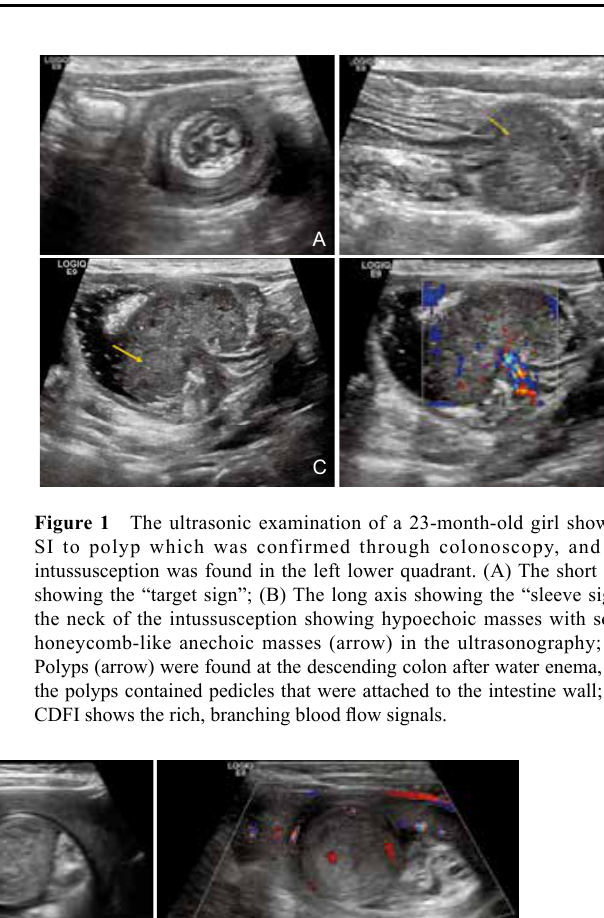
AB AB AB Figure 2 The ultrasonic examination of a boy (age: 7 years, 5 months) showing P-J Figure 2 The ultrasonic examination of a boy (age: 7 years, 5 months) showing P-J Figure 2 The ultrasonic examination of a boy (age: 7 years, 5 months) showing P-J Figure 2 The ultrasonic examination of a boy (age: 7 years, 5 months) showing P-J syndrome-induced SI which was confirmed by laparotomy. Ultrasound shows the features of syndrome-induced SI which was confirmed by laparotomy. Ultrasound shows the features of syndrome-induced SI which was confirmed by laparotomy. Ultrasound shows the features of syndrome-induced SI which was confirmed by laparotomy. Ultrasound shows the features of intussusception in the upper abdomen. (A) The long axis showing the “sleeve sign”, the neck of intussusception in the upper abdomen. (A) The long axis showing the “sleeve sign”, the neck of intussusception in the upper abdomen. (A) The long axis showing the “sleeve sign”, the neck of intussusception in the upper abdomen. (A) The long axis showing the “sleeve sign”, the neck of Figure 2 The ultrasonic examination of a boy (age: 7 years, 5 months) showing P-J syndrome-induced SI which was confirmed by laparotomy. the intussusceptions showing a polyp (arrow) with hypoechoic masses, and the echoes were the intussusceptions showing a polyp (arrow) with hypoechoic masses, and the echoes were the intussusceptions showing a polyp (arrow) with hypoechoic masses, and the echoes were Figure 2 The ultrasonic examination of a boy (age: 7 years, 5 months) showing P-J Figure 2 The ultrasonic examination of a boy (age: 7 years, 5 months) showing P-J Figure 2 The ultrasonic examination of a boy (age: 7 years, 5 months) showing P-J the intussusceptions showing a polyp (arrow) with hypoechoic masses, and the echoes were Ultrasound shows the features of intussusception in the upper abdomen. (A) The long axis showing the “sleeve sign”, the neck of the intussusceptions irregular within the masses in the ultrasonography; (B) The short axis showing the “target sign”, irregular within the masses in the ultrasonography; (B) The short axis showing the “target sign”, irregular within the masses in the ultrasonography; (B) The short axis showing the “target sign”, showing a polyp (arrow) with hypoechoic masses, and the echoes were irregular within the masses in the ultrasonography; (B) The short axis showing the irregular within the masses in the ultrasonography; (B) The short axis showing the “target sign”, syndrome-induced SI which was confirmed by laparotomy. Ultrasound shows the features of syndrome-induced SI which was confirmed by laparotomy. Ultrasound shows the features of syndrome-induced SI which was confirmed by laparotomy. Ultrasound shows the features of “target sign”, the neck of the intussusception (arrow) showing a polyp (arrow); (C) CDFI revealed dot-like and stripe-like signals of blood flow within the hypoechoic mass. intussusception in the upper abdomen. (A) The long axis showing the “sleeve sign”, the neck of intussusception in the upper abdomen. (A) The long axis showing the “sleeve sign”, the neck of intussusception in the upper abdomen. (A) The long axis showing the “sleeve sign”, the neck of the intussusceptions showing a polyp (arrow) with hypoechoic masses, and the echoes were the intussusceptions showing a polyp (arrow) with hypoechoic masses, and the echoes were the intussusceptions showing a polyp (arrow) with hypoechoic masses, and the echoes were irregular within the masses in the ultrasonography; (B) The short axis showing the “target sign”, irregular within the masses in the ultrasonography; (B) The short axis showing the “target sign”, irregular within the masses in the ultrasonography; (B) The short axis showing the “target